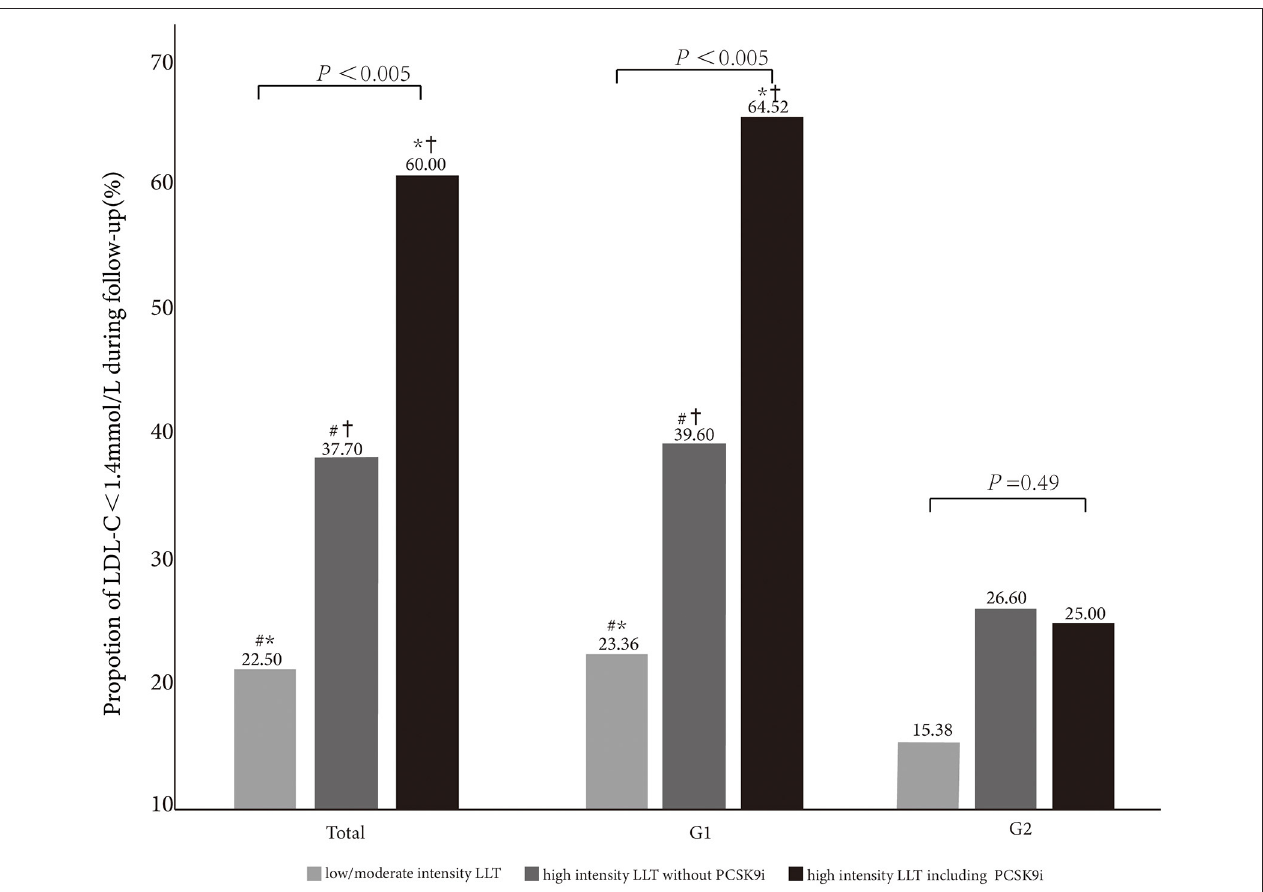
FIGURE 3 | Comparison of LDL-C < 1.4 mmol/L goal achievement under different LLT strategies in total and subgroups (G1 and G2). *, #, † indicate < 0.05 between the groups.